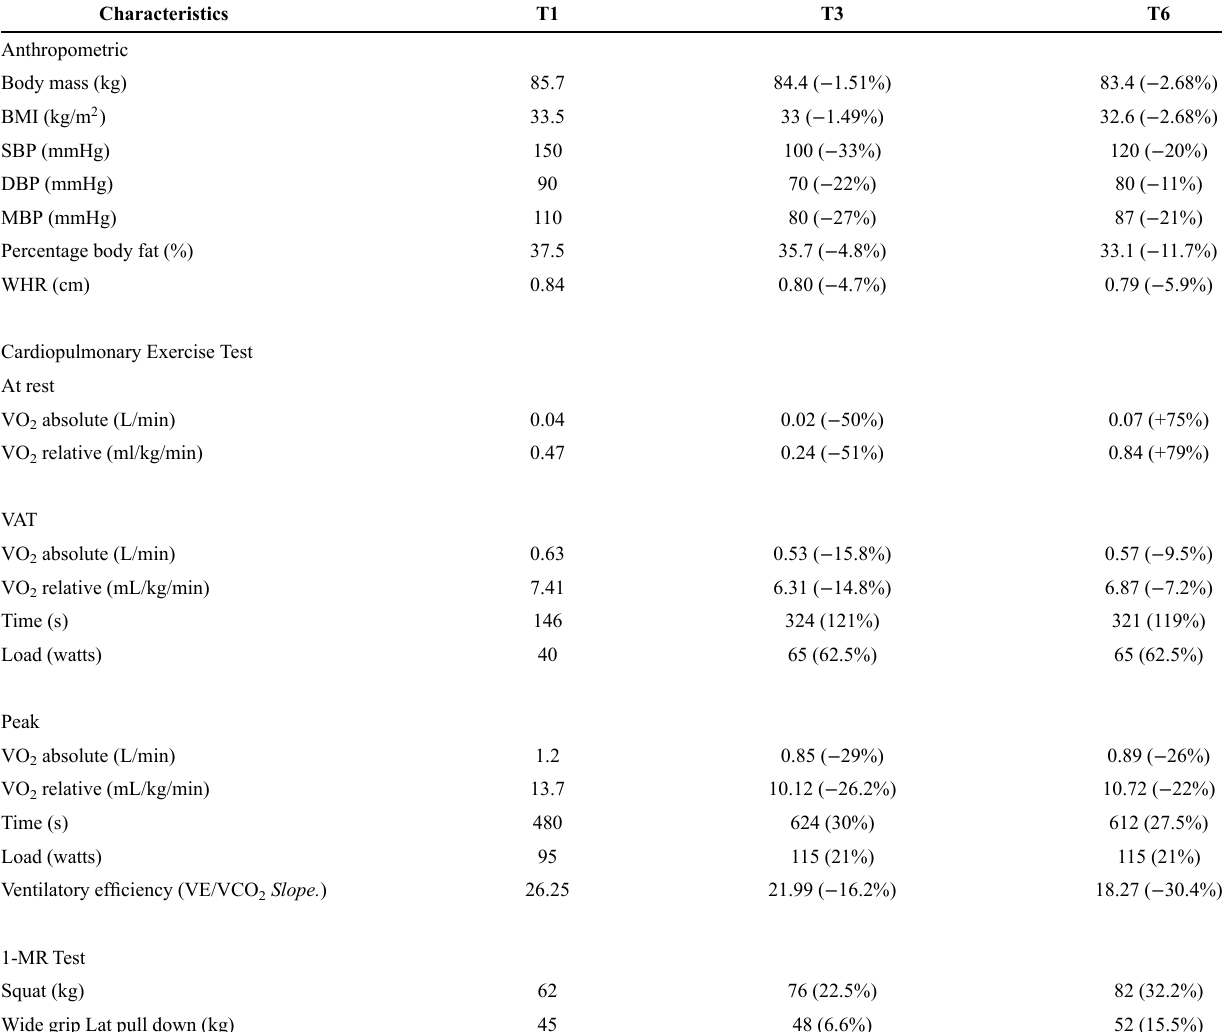
Table 1 - Anthropometric, clinical, strength, and hemodynamic values from a woman with Chagas Cardiopathy measured at baseline (T1), three (T3), and six (T6) months after 24-week combined physical training.